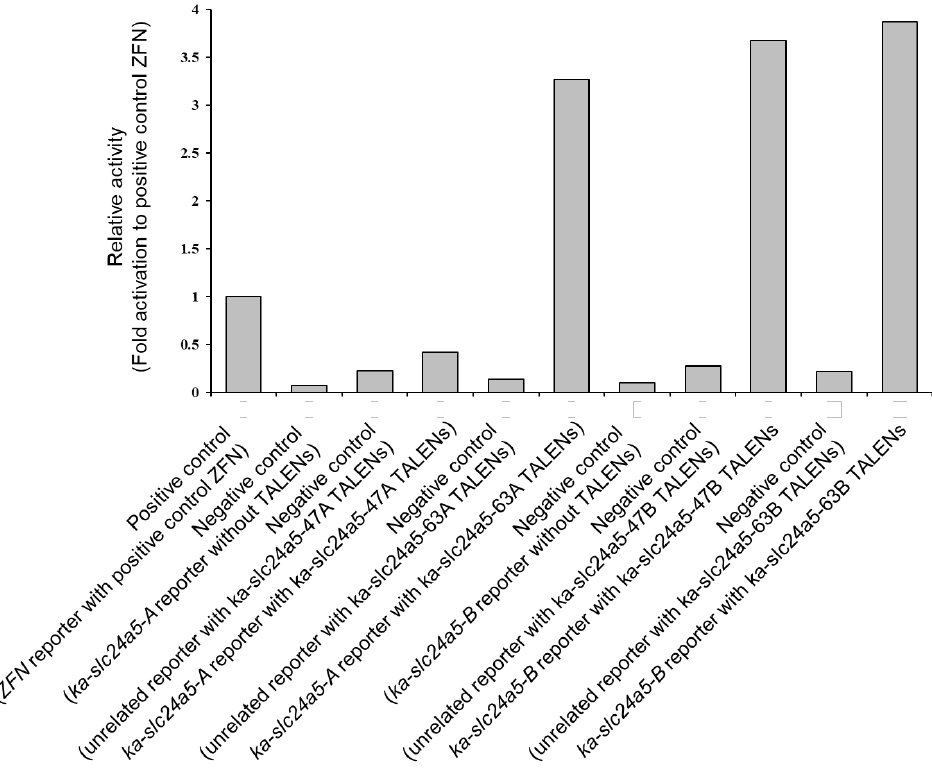
Figure 2. Activity evaluation of ka- slc24a5 TALENs by SSA assay. TALEN plasmids and the corresponding reporter plasmid, TALEN plasmids and unrelated reporter plasmid, or the reporter plasmid without TALEN plasmids were transfected into HEK293T cells. Fold activation scores against the positive control ZFN (pSTL-ZFA36 with the corresponding reporter) were calculated after the luciferase assay.